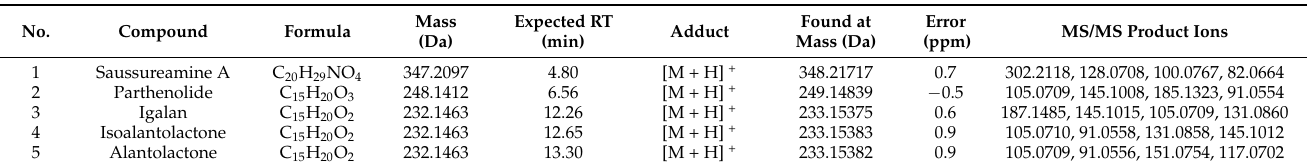
Figure 1. The base peak chromatogram of the sesquiterpene lactones-rich fraction of Inula helenium L. (SFIH). The representative base peak chromatogram of SFIH was obtained using LC-ESI-QTOF MS/MS analysis in negative ion mode. 1: Saussureamine A, 2: Parthenolide, 3: Igalan, 4: Isoalanto- lactone, 5: Alantolactone. Table 1. Identification and characterization of chemical components in SFIH using LC-ESI-QTOF MS/MS. RT = retention time.